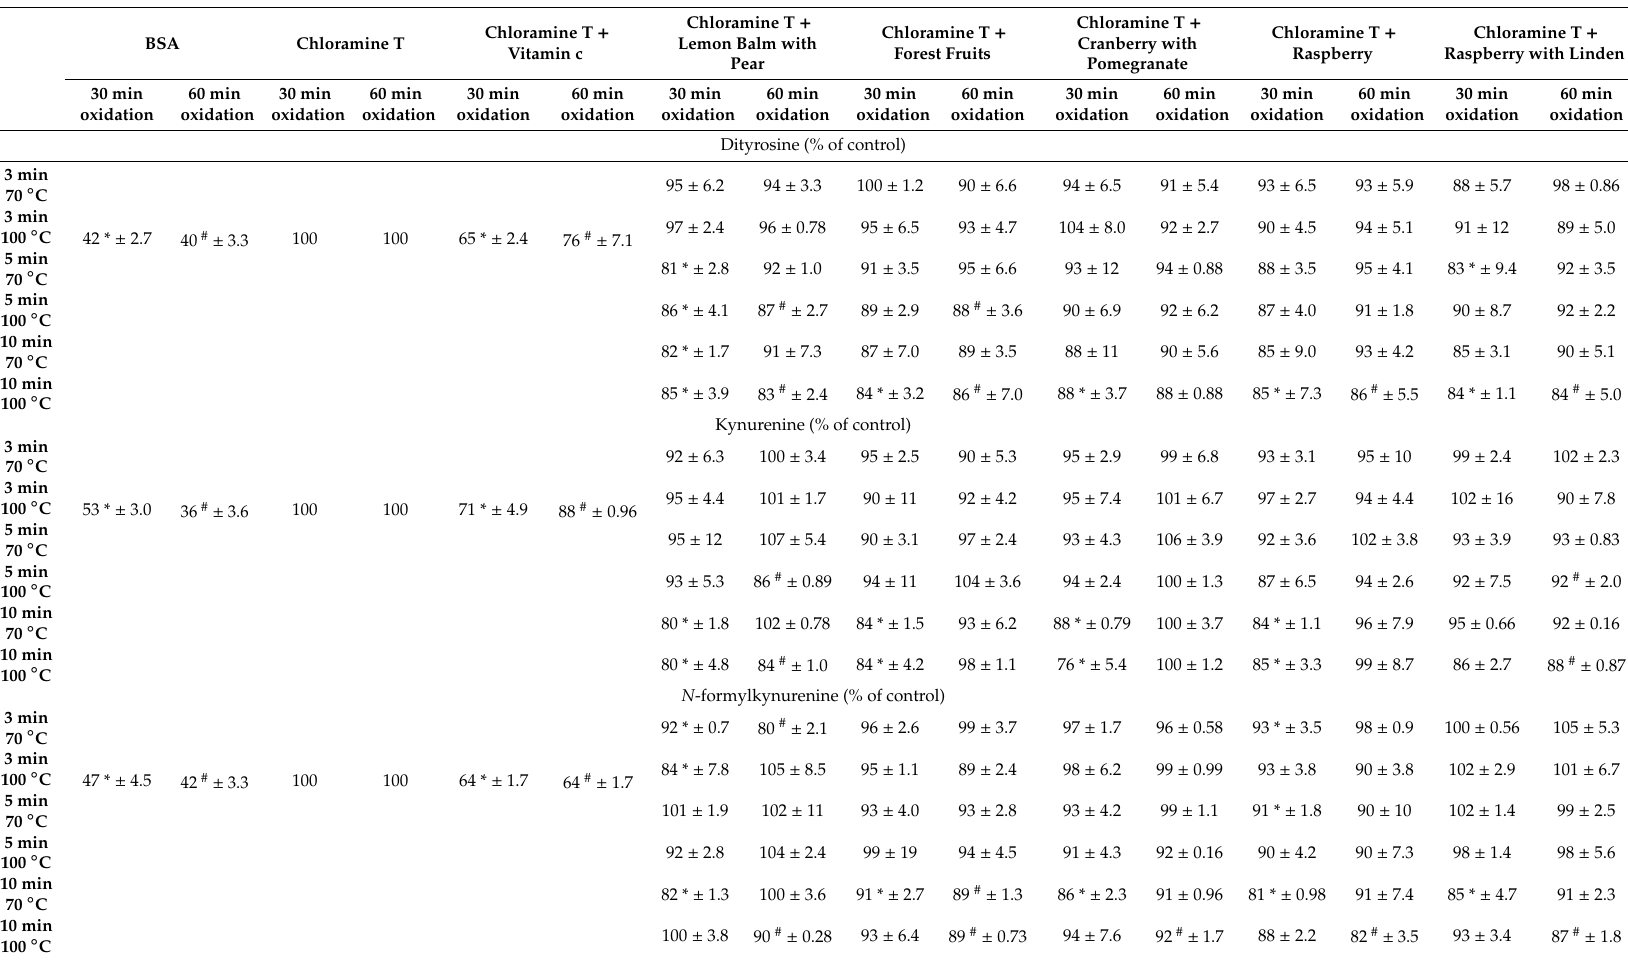
Table 7. The e ff ect of selected fruit tea extracts on protein glycooxidation in the model of bovine serum albumin (BSA) oxidized with chloramine T. AGE—advanced glycation end products; AOPP—advanced oxidation protein products; BSA—bovine serum albumin. * p < 0.05 vs. control (BSA + chloramine T, 30 min oxidation); # p < 0.05 vs. control (BSA + chloramine T, 60 min